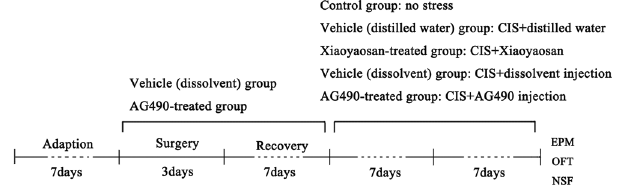
Figure 7. Experimental design. Prior to the experiment, the animals were allowed a 7-day adaptation period. Rats in the vehicle (dissolvent) group and AG490-treated group underwent stereotaxic surgery over 3 days and were provided a 7-day recovery period. Then, the rats in all groups, except for the control group, received a daily 3-h CIS procedure and were administered the appropriate drug for 14 consecutive days. The EPM test, OFT, and NSF test were conducted at the end of the